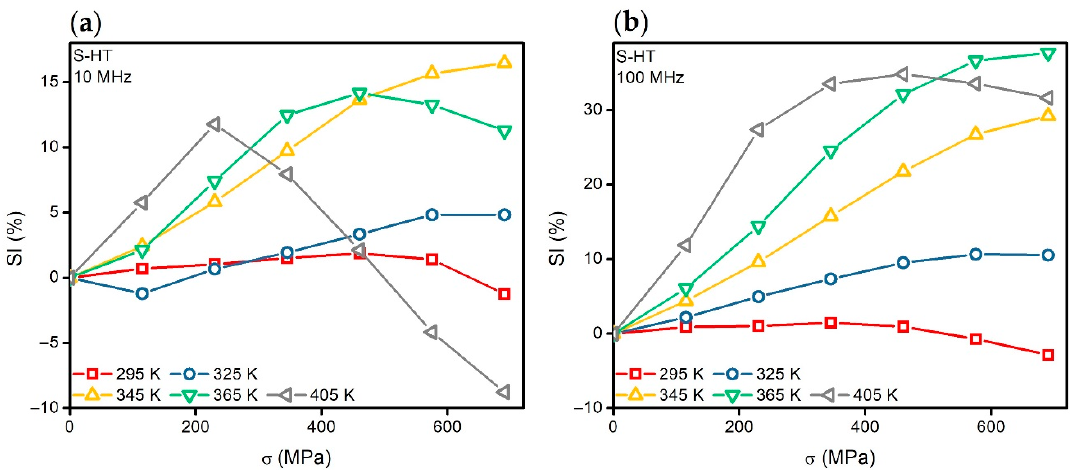
Figure 8. Stress-impedance dependencies SI ( σ ) of the S-HT amorphous ribbons. The dependencies were obtained at the alternating current frequencies of 10 MHz ( a ) and 100 MHz ( b ). They are given for the temperatures: 295, 325, 345, 365, and 405 K.